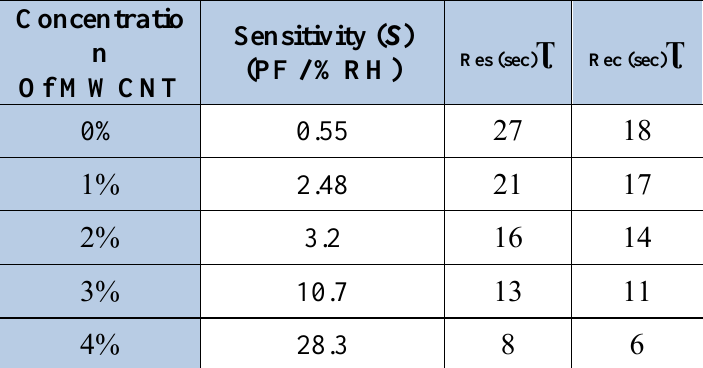
Table 1: The response time and the recovery time for PANI / MWCNT nanocomposite with different MWCNT